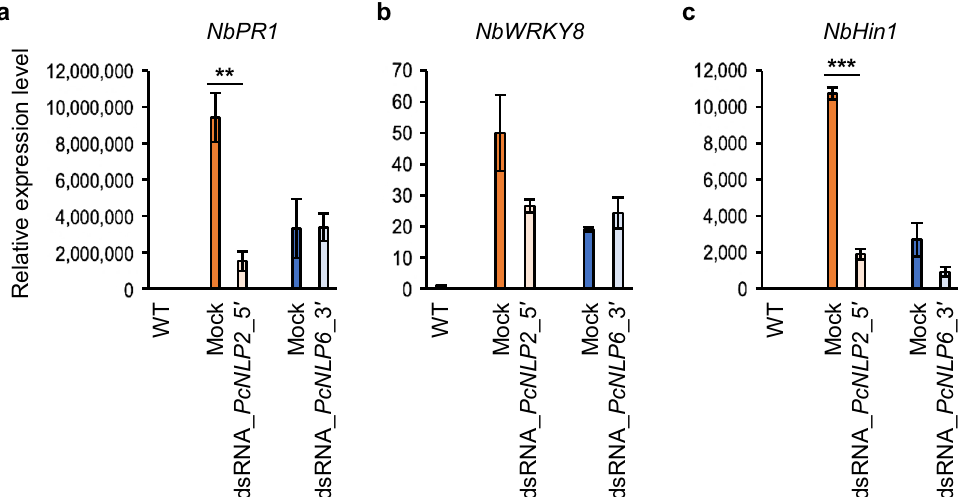
Fig. 4 Changes in expression of defense-related genes after treatment with dsRNAs targeting PcNLP2 and PcNLP6 , respectively. Quantification of the expression of defense-related genes a NbPR1 , b NbWRKY8 , and c NbHin1 using qRT-PCR. WT: Uninfected wild-type N . benthamiana ; Mock: P . capsica -infected N . benthamiana treated with dsRNA targeting Renilla luciferase ; dsRNA_ PcNLP2 _5 ′ : P . capsica -infected N . benthamiana treated with dsRNA_ PcNLP2 _5 ′ ; dsRNA_ PcNLP6 _3 ′ : P . capsica -infected N . benthamiana treated with dsRNA_ PcNLP6 _3 ′ . Data represent mean Significance is determined by Student’s t -test, ** P < 0.01 and *** P <